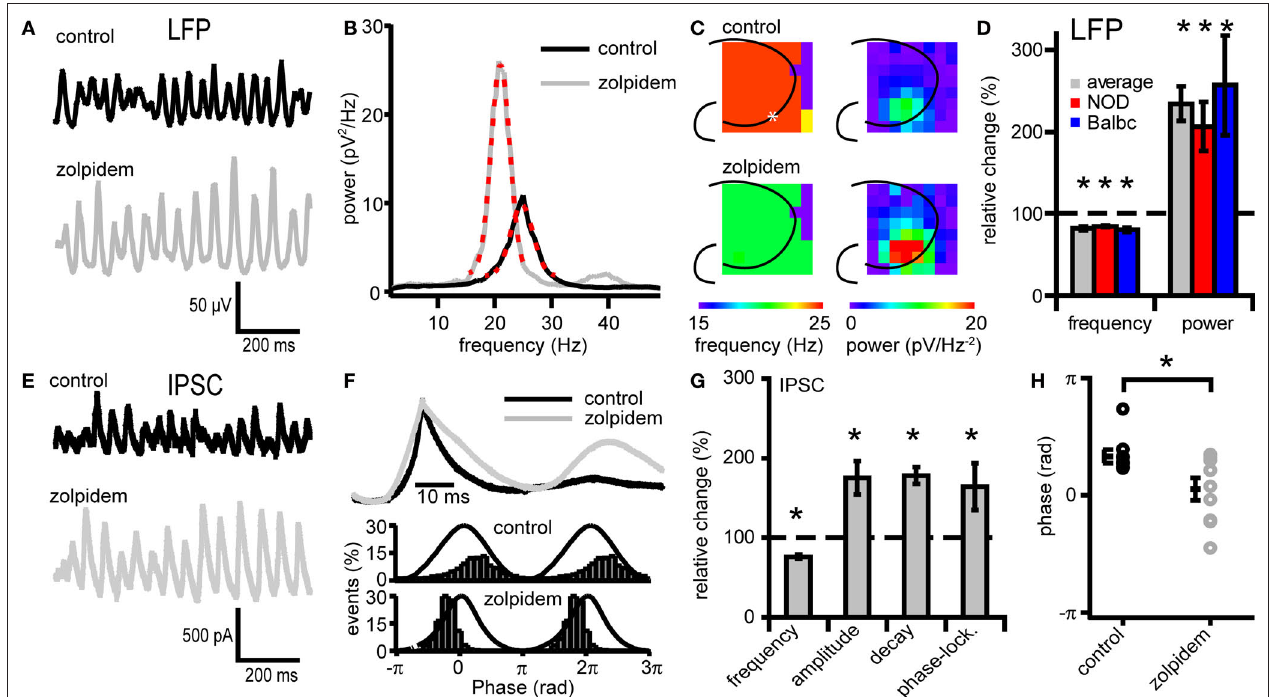
and increases the power in both NOD and Balbc mice ( n = 4 and n = 5 respectively, p < 0.05). (e) Example traces of IPSCs in CA3 pyramidal cells before and after zolpidem application from a NOD mouse. Traces correspond to the field potential traces in (A) . (F) Average IPSC normalized to peak values from one cell from a NOD mouse. Zolpidem increases the duration of the IPSC. (G) Zolpdem effects on IPSC frequency, τ decay times, amplitude and phase-locking relative to the field oscillation ( n = 4 and n = 5 respectively, p < 0.05). (H) Average phase of IPSCs in control and zolpidem. Zolpidem shifts the occurrence of IPSCs relative to the field ( p < 0.05). All data are normalized to control